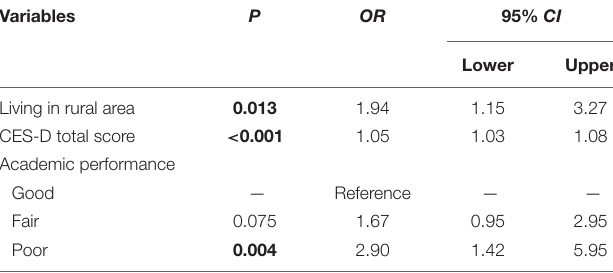
TABLE 2 | Demographic and clinical variables independently associated with internet addiction symptoms by binary logistic regression